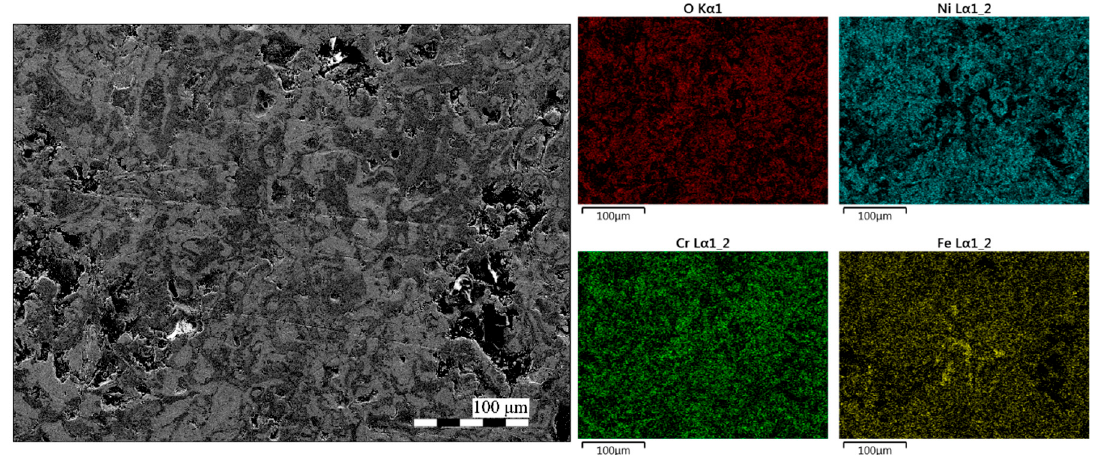
Figure 7. An EDX image of the raw unablated element with the upper surface ground away.